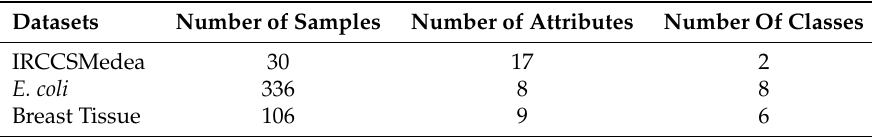
Table 1. Description of the three